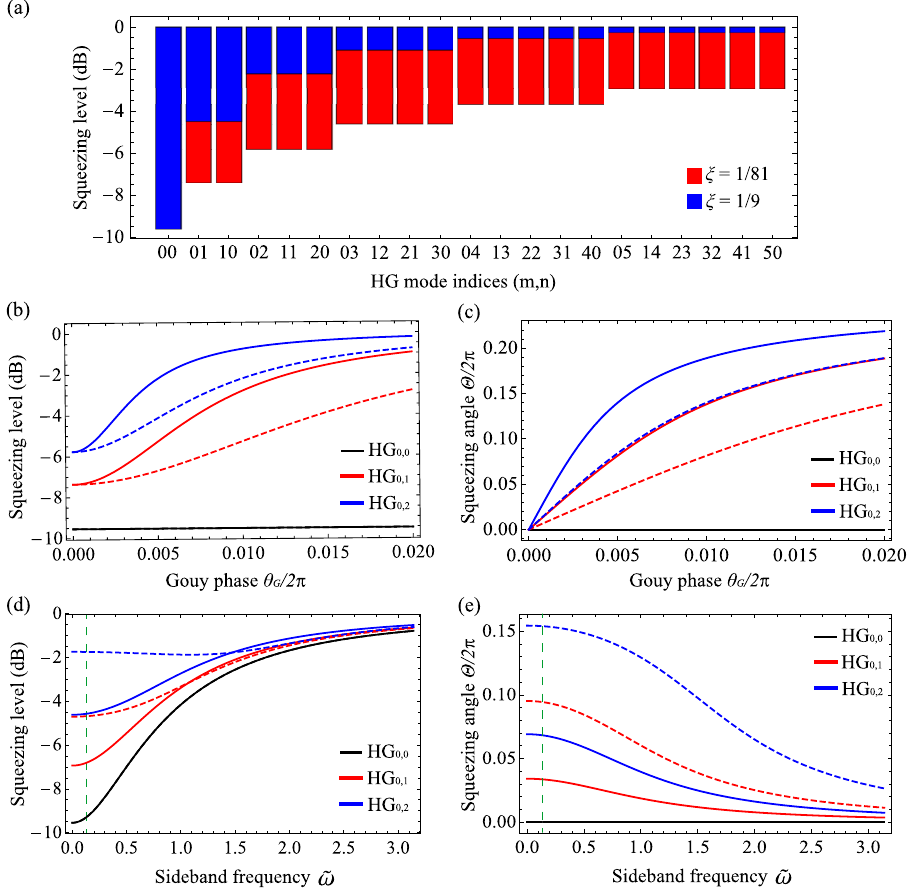
1 / 9 and Figure 2. ( a ) Squeezing levels of multimode squeezed light for different focusing parameters of ξ = ω ξ 0.1, T l 0, 0, 1 / 2 , and θ G 0 . In both cases, the squeezing levels in HG 00 1 / 81 , when T i g 00 = = ˜ = ˜ = = = are 9.5 dB. Effect of the Gouy phase shift θ G on the squeezing levels in ( b ) and the squeezing angles in ( c ) for 0.1 , and the dashed lines are different HG mn modes and the transmittance T i of M 2 . The solid lines are for T i = ω 0.2 . We use ξ 1 / 2 . Dependence of the squeezing levels in ( d ) and 0 , and 1 / 81 , T l 0 , g 00 for T i = ˜ = ˜ = = = ω . The solid and dashed lines are for θ G / 2 π 0.002 the squeezing angles in ( e ) on the sidebands frequency ˜ = 0.1 , T l 1 / 2 . For the later analyses in 0.006 , respectively. We use ξ 1 / 81 , T i 0 , and g 00 and θ G / 2 π = ˜ = = = = ω π/ 25 will be used, which is indicated as the vertical dashed Figs. (5, 6, 8), sideband frequency of ˜ = Figure 2b,c show the effects of the Gouy phase shift θ G on the generated light. The Gouy phase creates the detuning ˜ (cid:31) mn , which affects both the squeezing level and the squeezing angle. For small detunings, the squeezing level and the squeezing angle remain similar to the ideal self-imaging case, but as θ G increases, the squeezing level � 2 X (�) mn (ω) gradually degrades to zero, and the squeezing angle (cid:31) increases to π/ 2 . Such effects are stronger for a ˆ � � smaller transmittance T i and a higher HG mn mode, as expected from Eq. (22). In addition, the squeezing level and (cid:31) mn ω , as shown in Fig. 2d,e. As HG 00 mode exhibits 0 , the squeezing angle depend on the sideband frequency ˜ = ˜ it behaves as a common OPO, where the squeezing level decreases while the squeezing angle remains constant as ω increases. On the other hand, for higher modes where (cid:31) mn 0 , both of the squeezing level and the squeezing ˜ ˜ �= (cid:31) mn returns to zero as ω . The rotated squeezing angle due to non-zero angle depend on the sideband frequency ˜ ˜ ω increases. The squeezing level, in most cases, gradually decreases to zero by increasing ω , but there is a special ˜ ˜ case showing a non-monotonic behavior (the blue dashed line for HG 02 in Fig. 2d), which is because a non-zero ω makes the minimum value for � 2 ω � 2 1 for g 2 X (�) mn (ω) : such a case can take place at value of mn − mn − ˜ ˜ ˆ ˜ � � ˜ = (cid:31) > � 2 1 , which can be derived from Eq. (21). g 2 mn + mn ˜ ˜